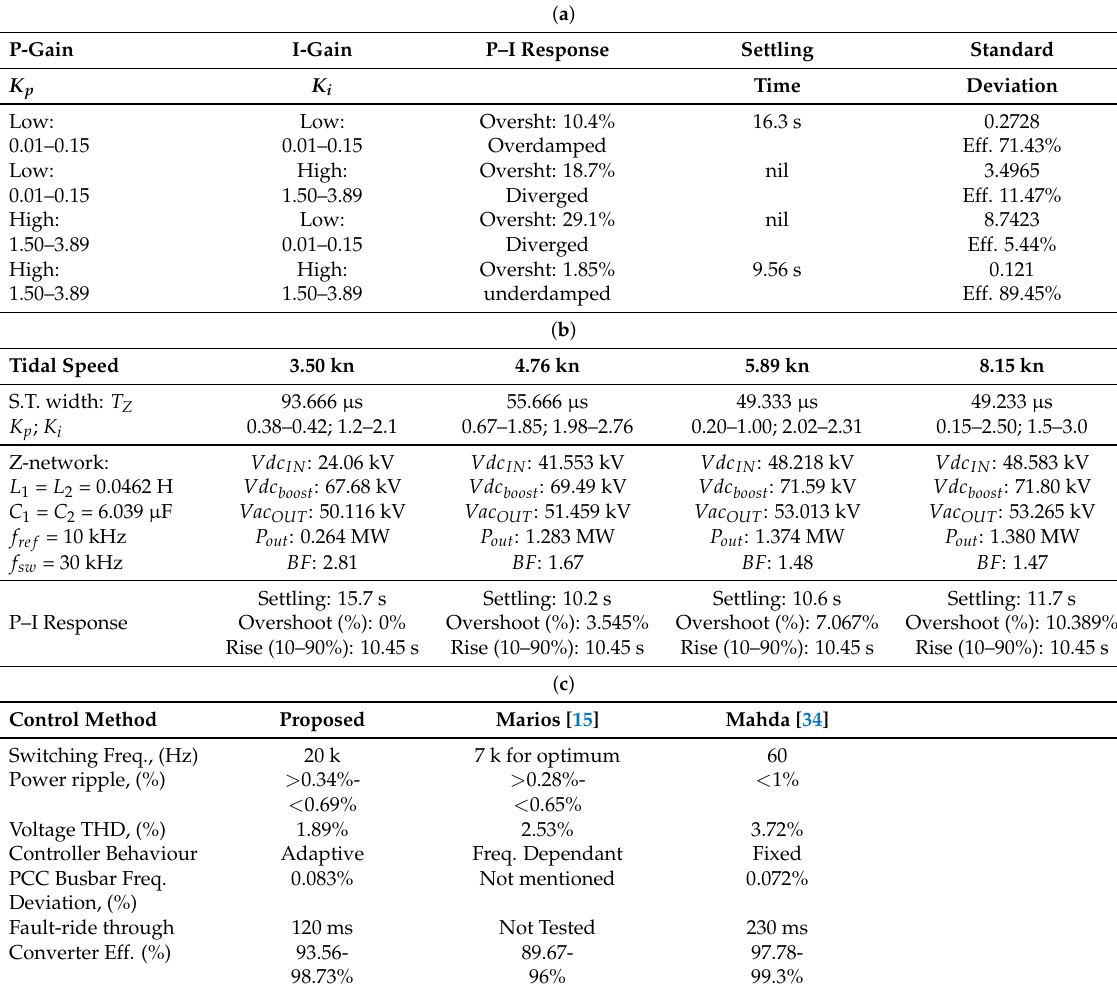
Table 4. ( a ) ZSI K p and K i controller evaluations ( K a = 0.05, K t = 0.1); ( b ) single ZSI operations with